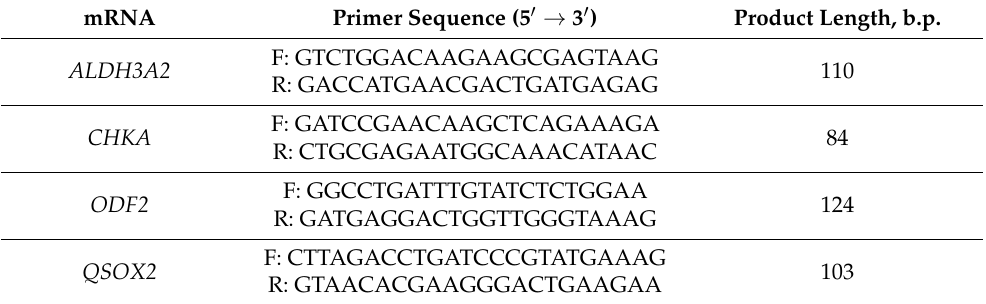
Table 7. Primer sequences for assessing the level of mRNA